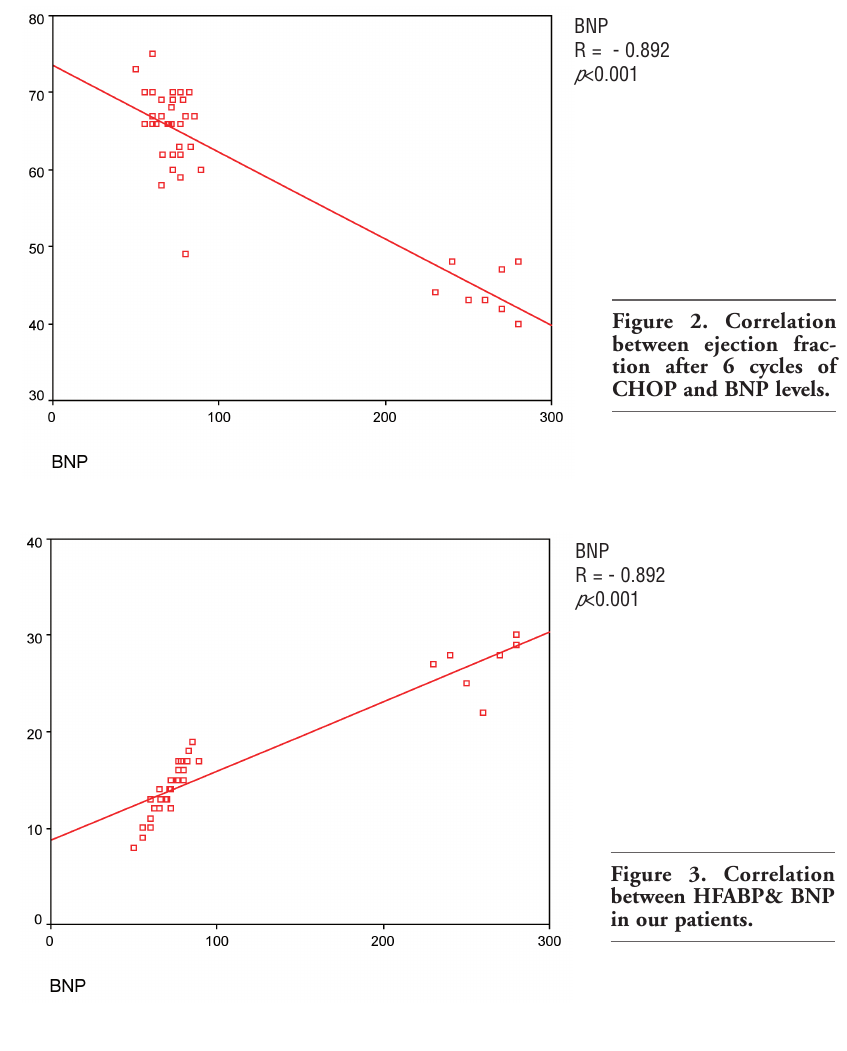
Figure 3. Correlation between HFABP& BNP in our patients.